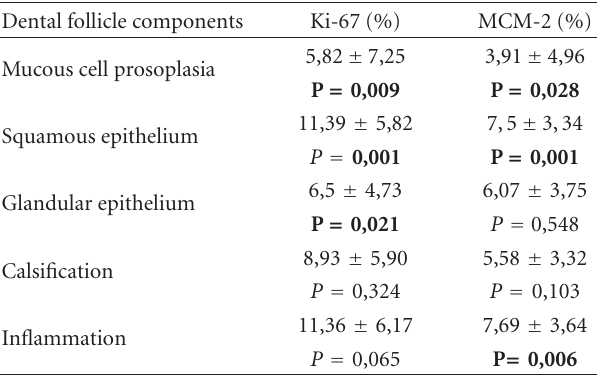
Table 3: The mean Ki-67 ve MCM-2 expressions in the components of dental